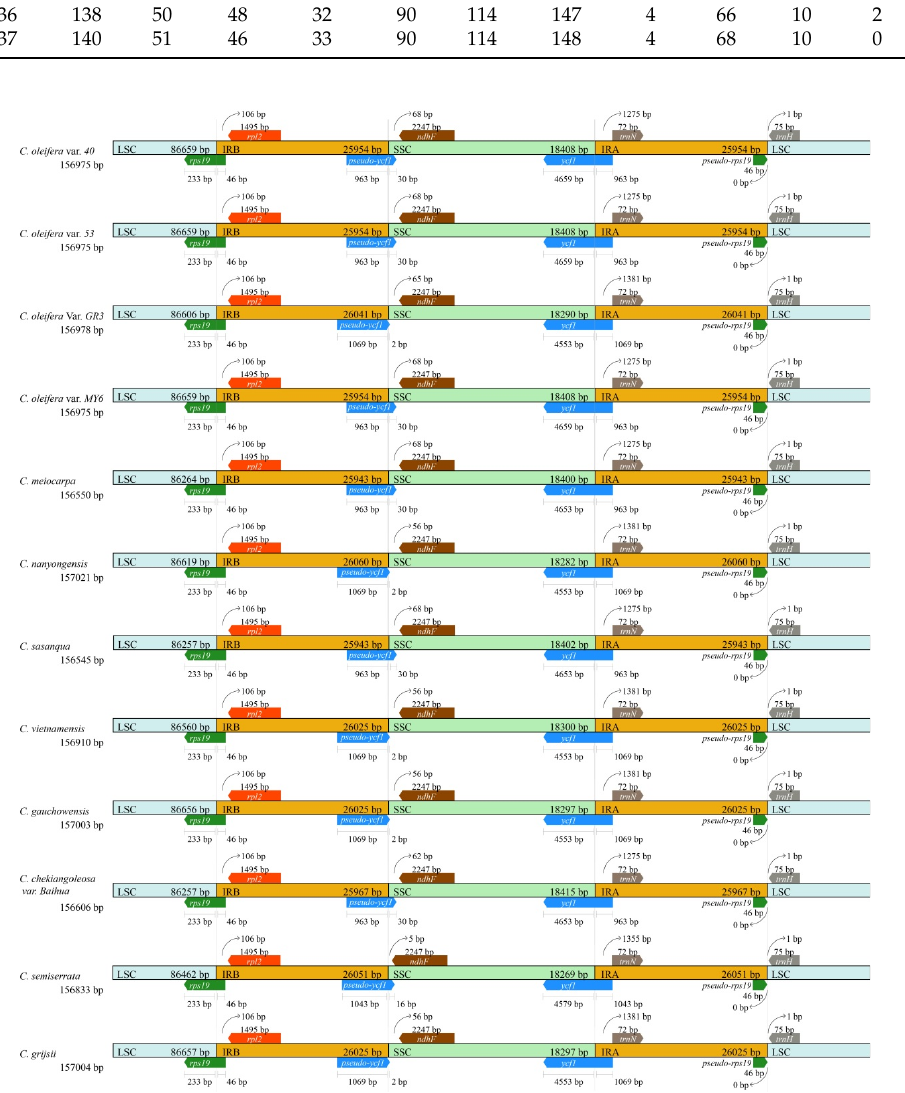
Figure 2. The comparison of the LSC, IR, and SSC border regions in the 12 Camellia chloroplast genomes.